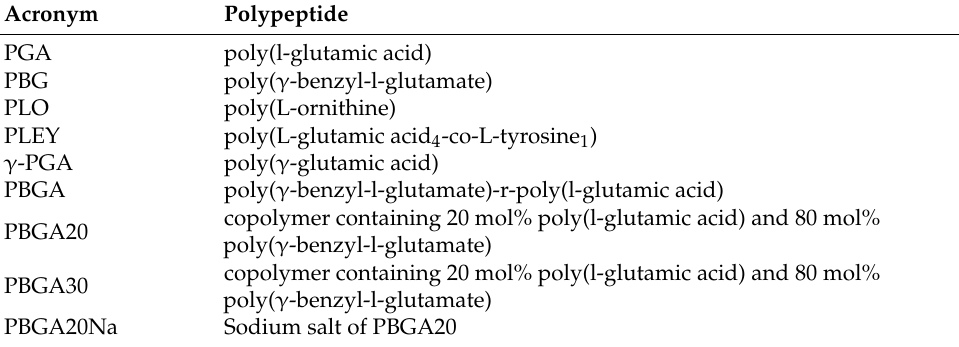
Table 2. Discussed polypeptide